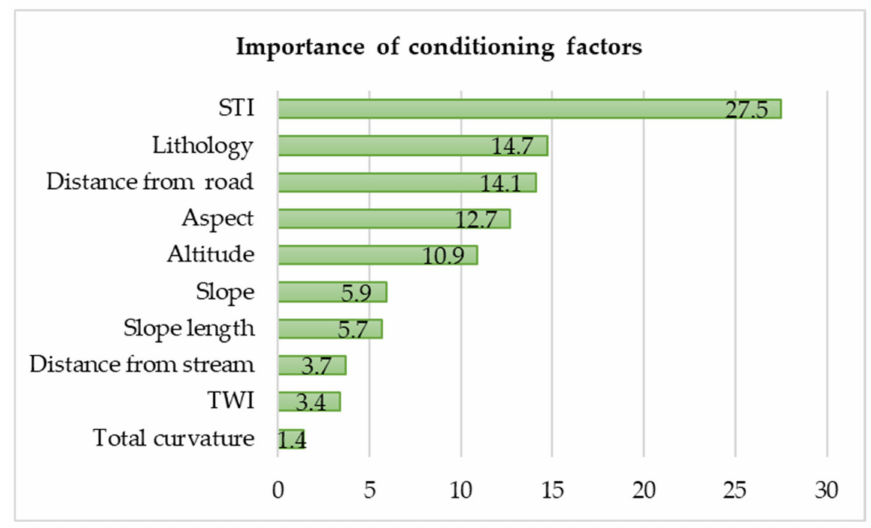
Figure 9. Variable importance analysis derived from RF corrected datasets created by